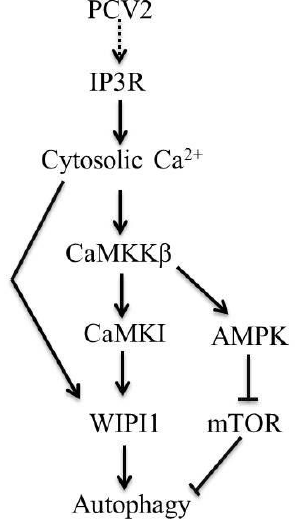
Figure 9 . A proposed model of Ca2+ signaling in PCV2-induced autophagy in PK-15 cells. PCV2-nduced autophagy likely results from activation of IP3R and elevation of cytosolic Ca2+, which